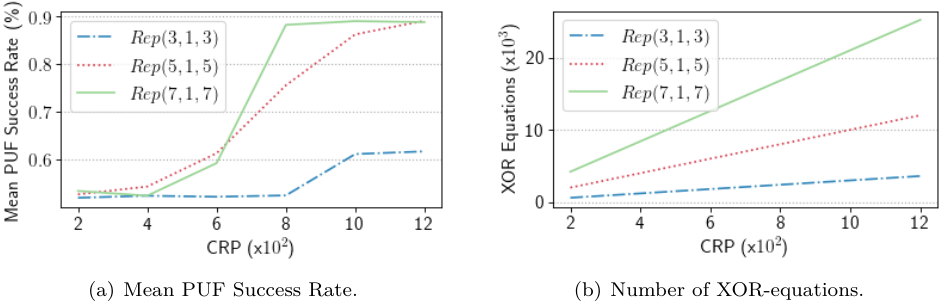
Figure 6: Comparison of three repetition codes dependent on the number of XOR-equations which can be